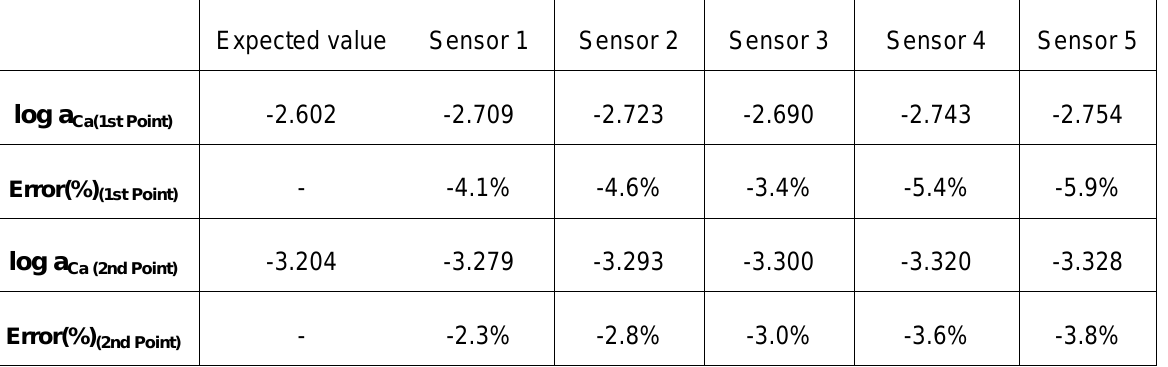
Table 2. Processing of experimental points in figure 5 to validate the system